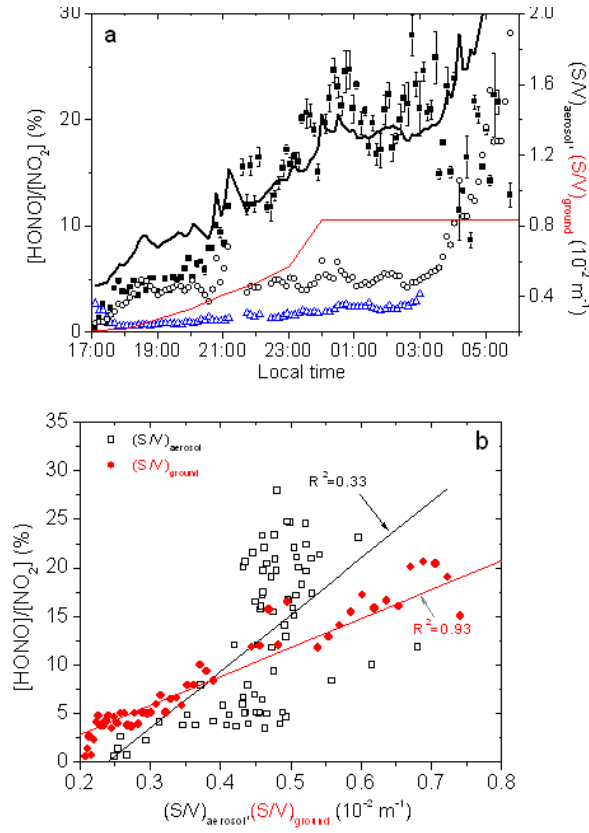
Fig. 5. (a) Observed [HONO]/[NO 2 ] (square), aerosol surface den- sity (open circle), calculated [HONO]/[NO 2 ] due to Reaction (4) (blue triangle), ground reactive surface density (red line) and total surface density or (S/V)aerosol + (S/V)ground (black line) at 21–22 January 2003. (b) Linear correlations of [HONO]/[NO 2 ] to aerosol surface density and ground reactive surface